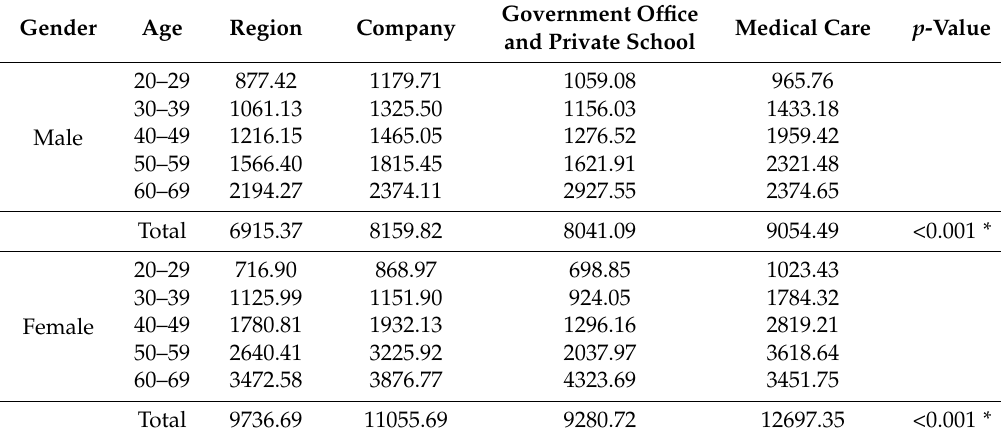
Figure 2. Number of patients with lumbar disc herniation (LDH) of 100,000 individuals according to gender and age (2004–2010) *. * According to the Chi-square test, there was a statistically significant difference of frequency with respect to gender and age ( p -value < 0.001). Table 3. Number of patients with LDH of 100,000 individuals according to gender, age and health insurance eligibility (2004–2010).